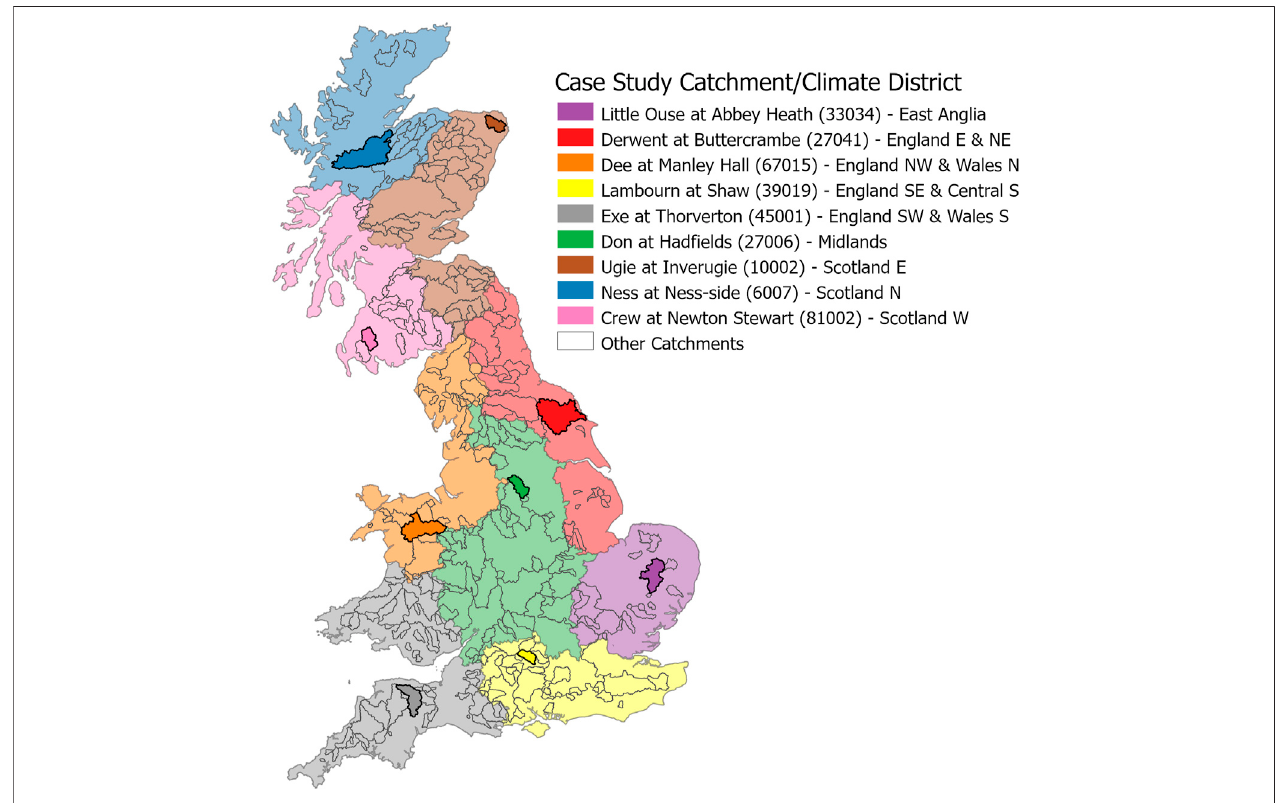
FIGURE 1 | Location of the nine case study catchments. Shading indicates the Met Of fi ce Climate Districts for Great Britain. Numbers in brackets are the Catchment ID from the United Kingdom National River Flow Archive.